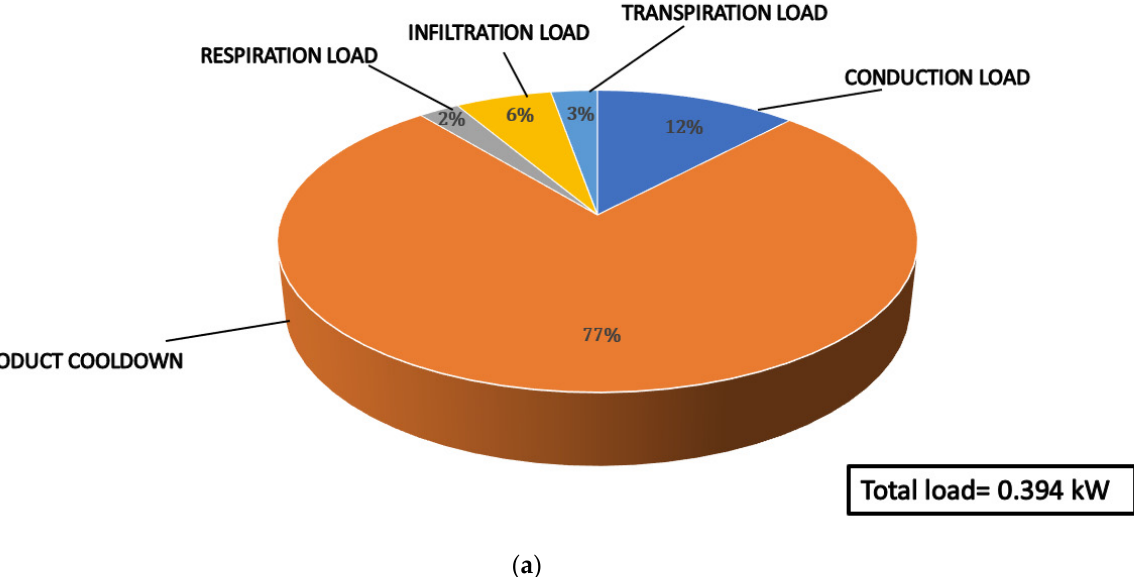
( b ) Figure 5. Representative heat load for a single mini container (MC) containing tomatoes in: ( a ) Phoenix, and ( b ) Chicago. 4.2. Energy Consumption and GHG Emissions For their characterization, refrigeration capacity and fuel consumption of conventional reefers are usually measured at full load as per local and international standards. These units are then optimized for a full-load operation, even if in most cases they operate in other modes where performance may be quite different. Several studies have agreed that it is necessary to measure the energy efficiency of the equipment in other operating modes, especially under partial load [37]. Reference [38] presented results of typical refrigeration duty and fuel consumption of self-contained mechanical road refrigeration equipment. The average volume and